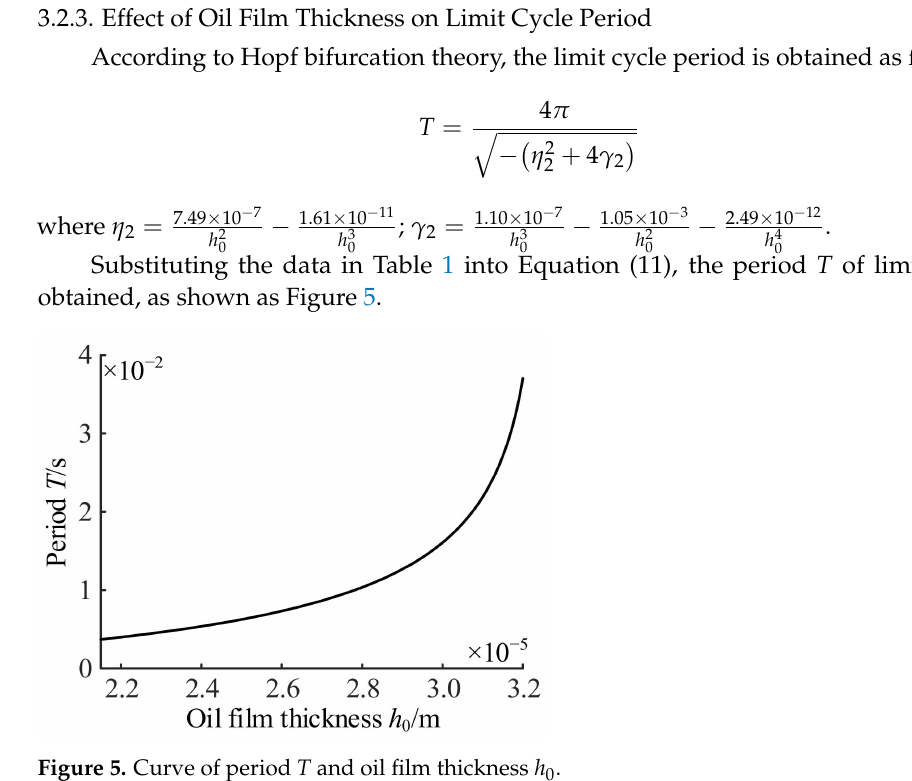
Figure 5. Curve of period T and oil film thickness h 0